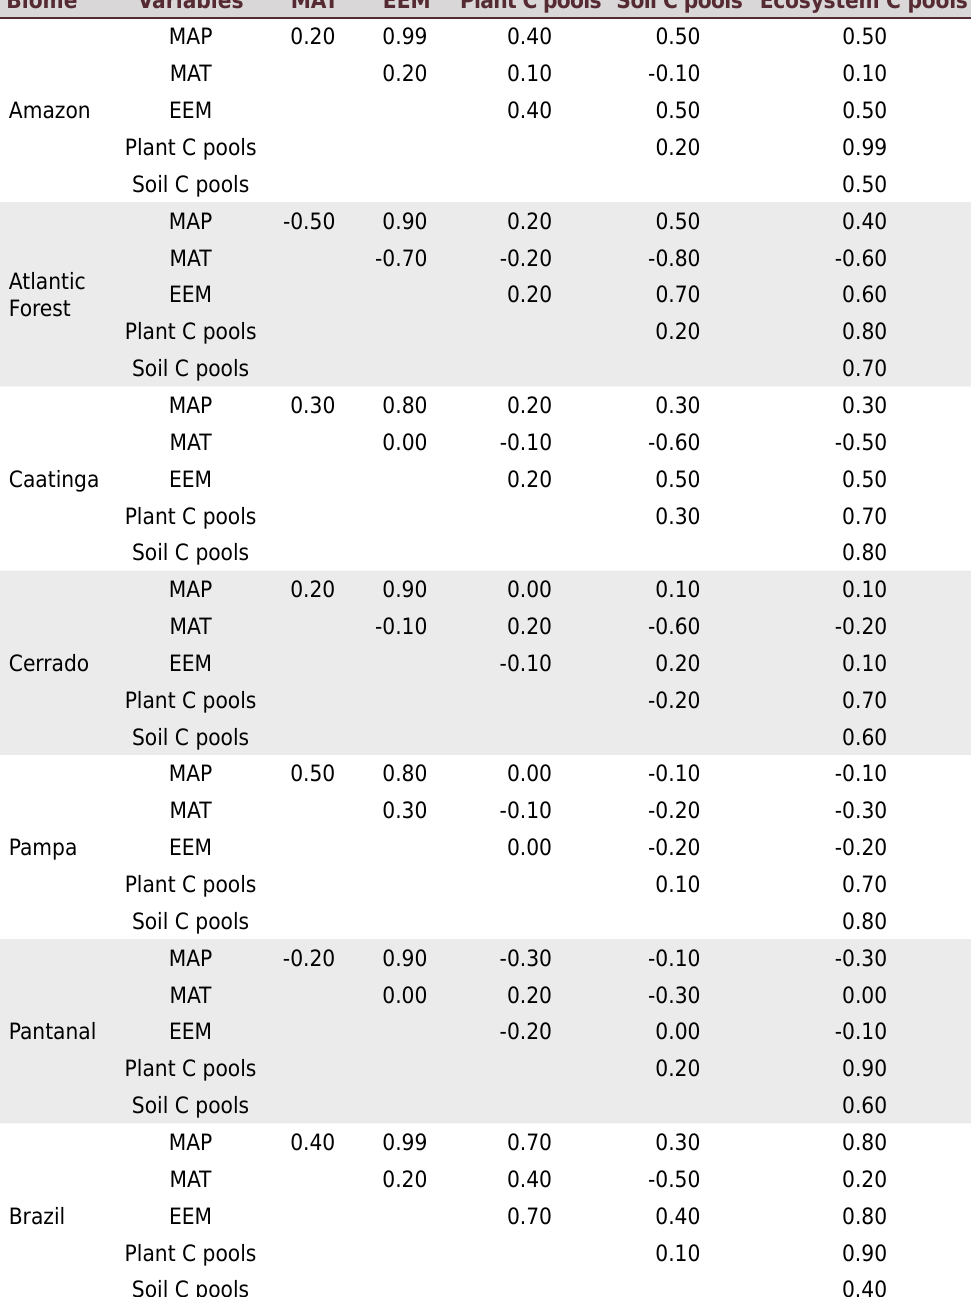
Table 1. Pearson’s correlation coefficients ( r ) for the spatial distribution of mean annual precipitation (MAP), temperature (MAT), ecosystem effective moisture (EEM), plant and soil C pools across the six Brazilian biomes and the whole country